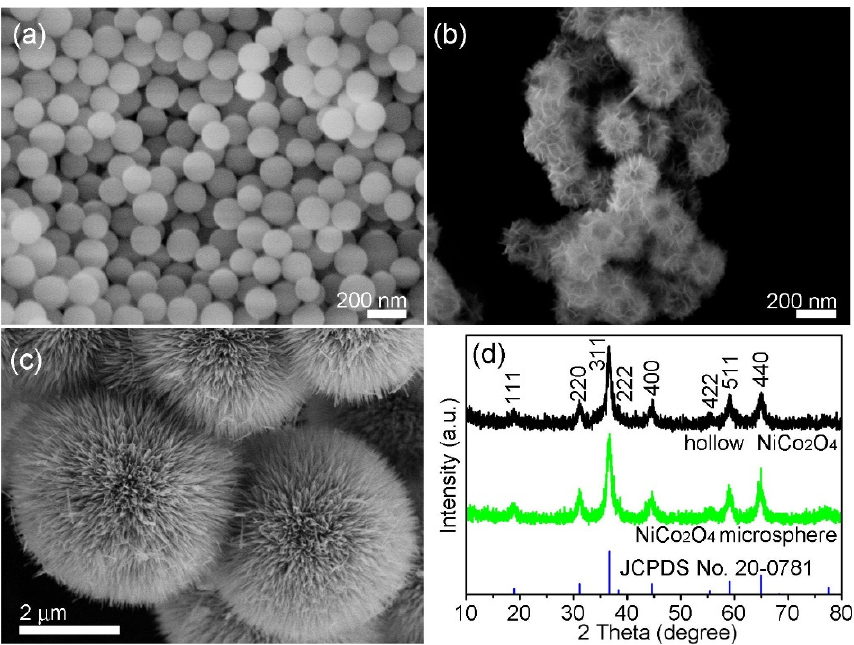
Figure 2. SiO 2 nanospheres and NiCo 2 O 4 nanospheres. SEM images of ( a ) SiO 2 nanospheres, ( b ) hol- low NiCo 2 O 4 nanospheres, ( c ) NiCo 2 O 4 microspheres, ( d ) XRD patterns of hollow NiCo 2 O 4 nano-